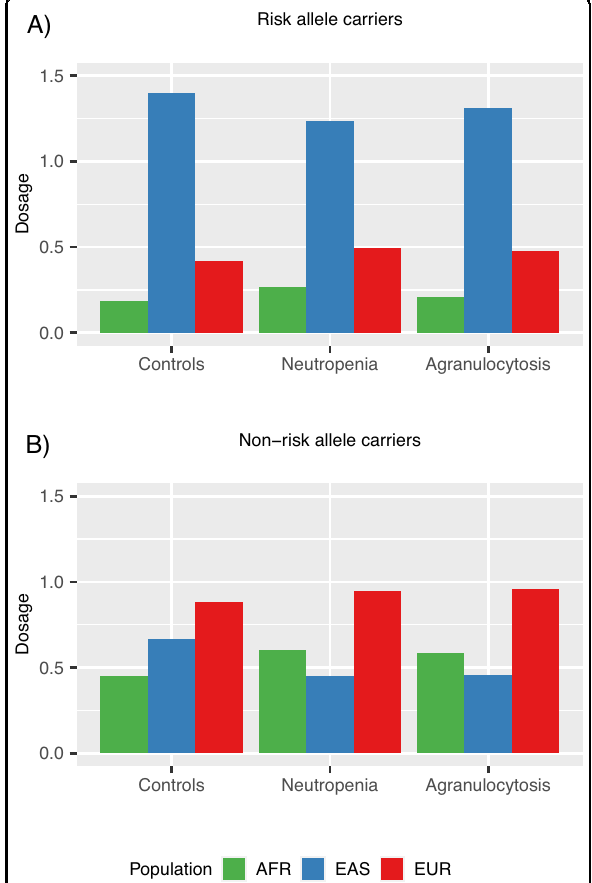
Fig. 1 Local ancestry dosage estimates. Local ancestry dosage estimates of risk allele ( A ) and non-risk allele carriers ( B ) were estimated by ELAI using 1KG AFR, EAS and EUR super populations as reference (green = AFR, blue = EAS, red = EUR). Means for the region of interest were averaged across 1 kb up and downstream from rs113332494. Risk allele status was de fi ned using best guess genotypes with posterior probability >